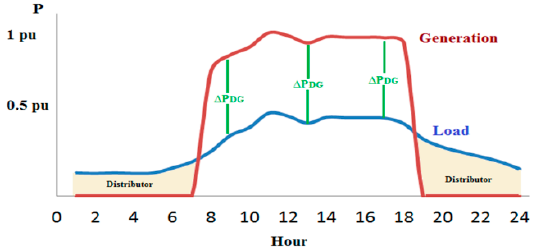
Figure 3. MOR Model 1 with one operating interval for the biogas DG and availability to distributor.